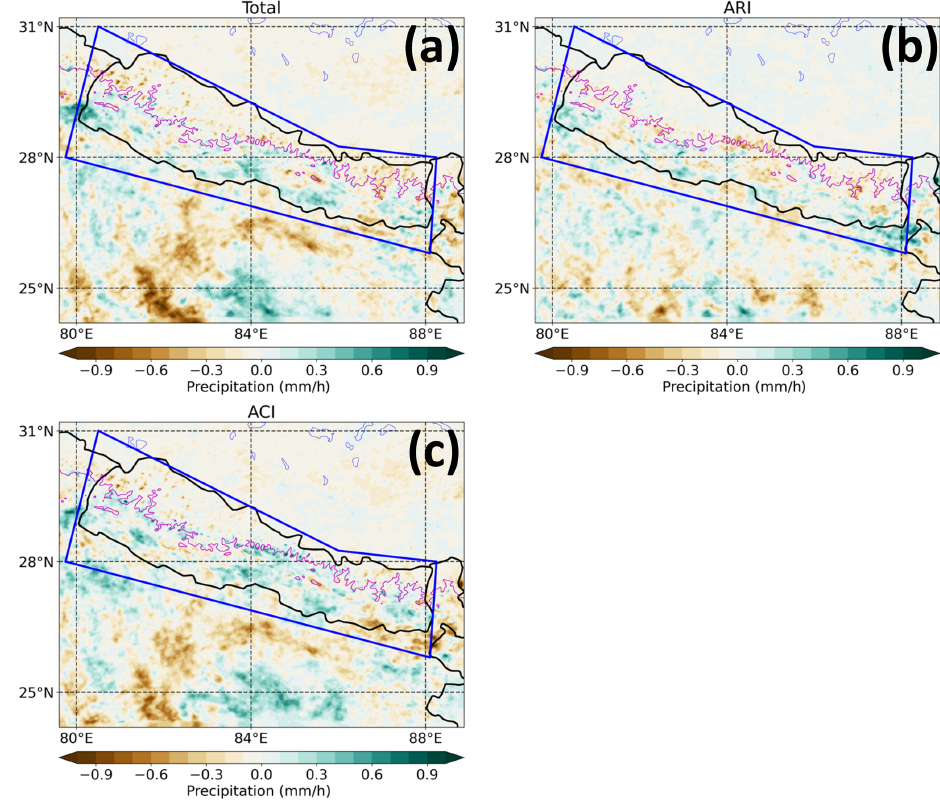
Figure 7. Spatial distribution of the differences in hourly mean precipitation due to the (a) total aerosol effect (CTL–CLEAN), (b) ARI effect (CTL–NoARI), and (c) ACI effect (NoARI–CLEAN). The blue-colored polygon represents the CenHim, whereas the pink-colored contour indicates the 2000ma.s.l. terrain